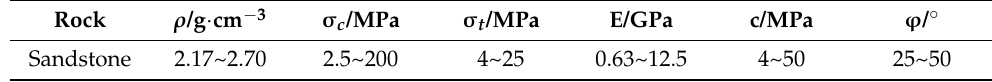
Table 1. Range of physico-mechanical parameters of sandstone [33]. Rock